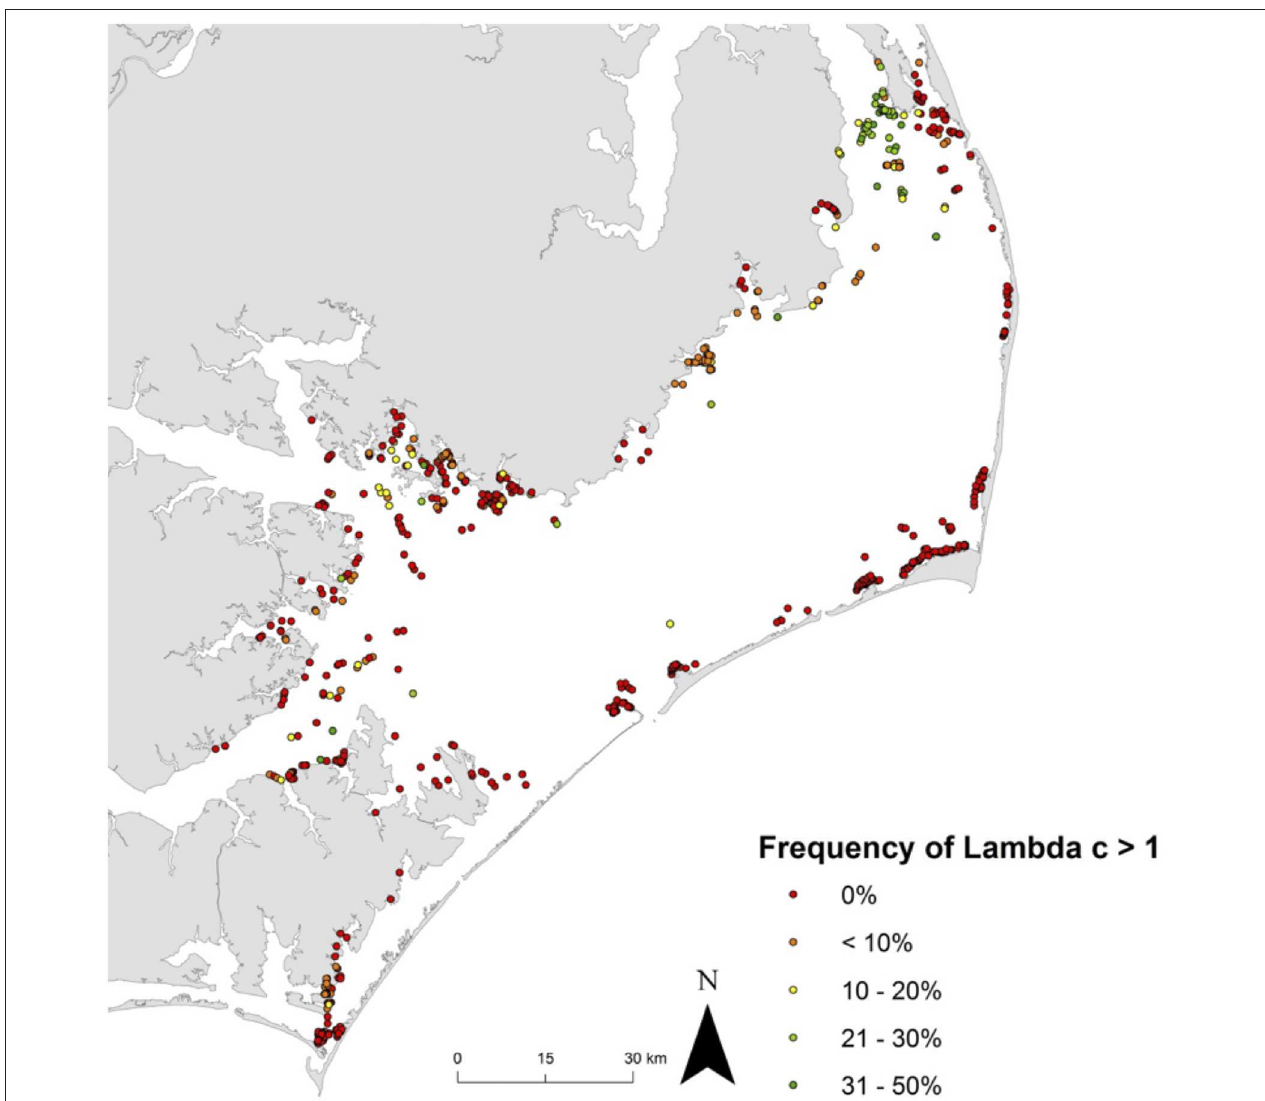
FIGURE 9 | Spatiotemporal variation in metapopulation source vs. sink status for eastern oyster Crassostrea virginica . Frequency of λ c ≥ 1 at all reefs across the five-year model time frame (assuming a larval mortality rate of 10% day − 1 ). λ c ≥ 1 indicates that a reef functioned as a source during time t , and λ c < 1 as a sink. Green dots represent frequent ‘source’ reefs (i.e., λ c ≥ 1, 31-50% of the time), red dots represent ‘sink’ reefs (i.e, λ c ≥ 1, 0% of the time). Figure adapted with permission (S. Theuerkauf, copyright holder) from Theuerkauf